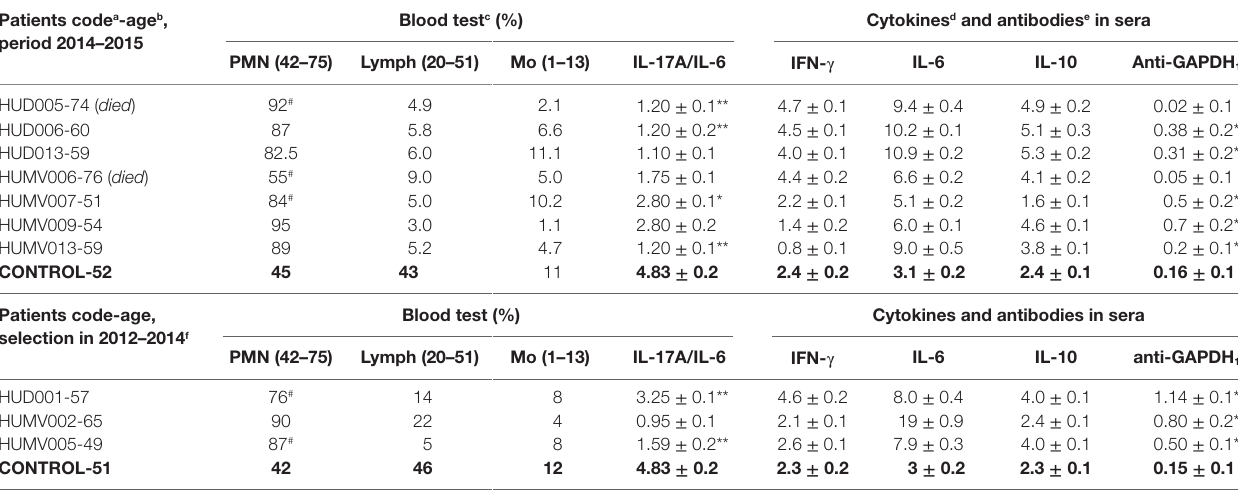
Supplementary Material). These results indicate that impairment of the Th17/Th2 balance toward Th2 responses may present a risk factor leading to fatal